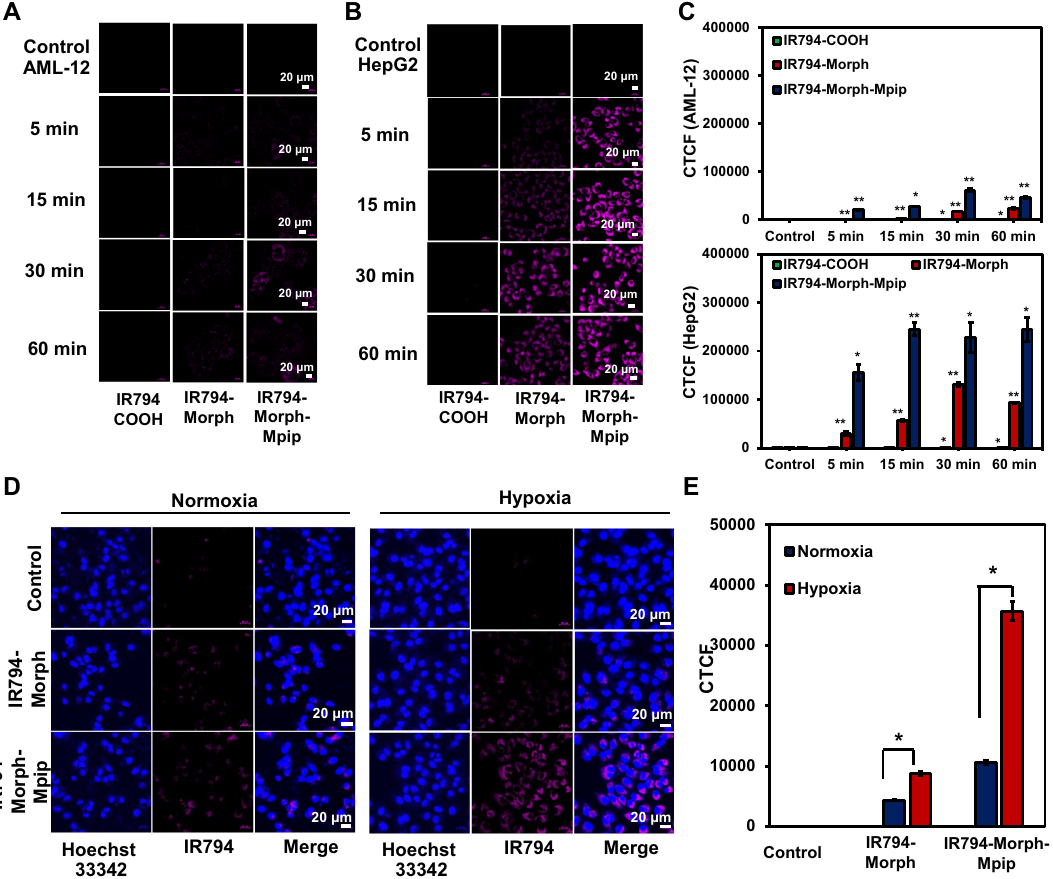
Figure 6. Confocal images of ( A ) AML12 and ( B ) HepG2 cells obtained using a laser scanning confocal microscope (Nikon A1Rsi, 63 × oil immersed optics) incubated with 1 μM of IR794 for 5–60 min. ( C ) Quantitative fluorescent intensity represented as corrected total cell fluorescence (CTCF), which were quantified using ImageJ and represent the mean ± SD (from three independent experiments, 30 cells/set). ( D ) Confocal images of HepG2 cells incubated with 0.5 μM of IR794-Morph and IR794-Morph-Mpip for 5 min under normoxia and hypoxia conditions. ( E ) Quantitative CTCF quantified using ImageJ and represent the mean ± SD (n = 3, 30 cells/set). Statistical analysis is based on T-test (*P < 0.05, **P < 0.01, ***P < 0.001) where the comparison between the control and different incubation duration (for each compound) is marked in C and the comparison between normoxia and hypoxia is marked in ( D ). Scale bar = 20